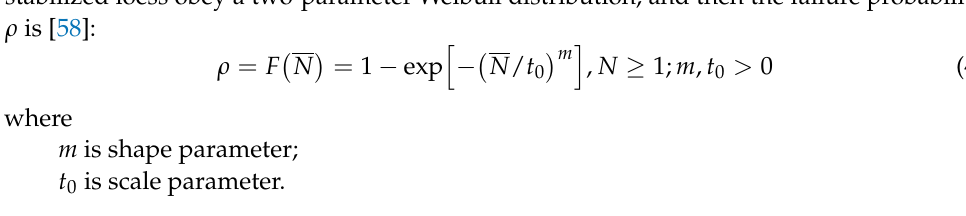
Table 4. The fatigue test results of cement-stabilized